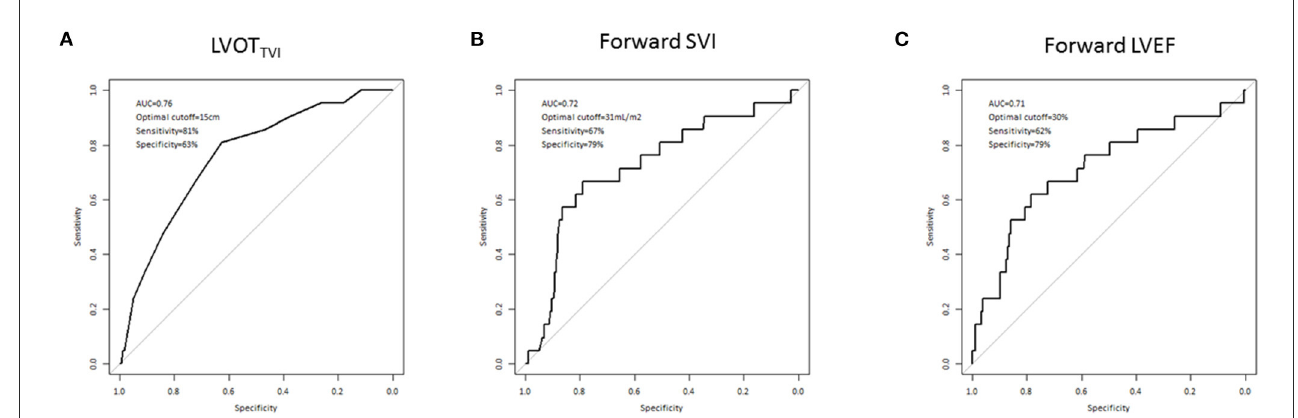
FIGURE2 Optimal thresholds for LVOT TVI (A) , forward SVi (B) , and forward LVEF (C) in predicting post-operative LV systolic dysfunction in 198 patients undergoing mitral valve repair for severe DMR according to ROC curve analysis.